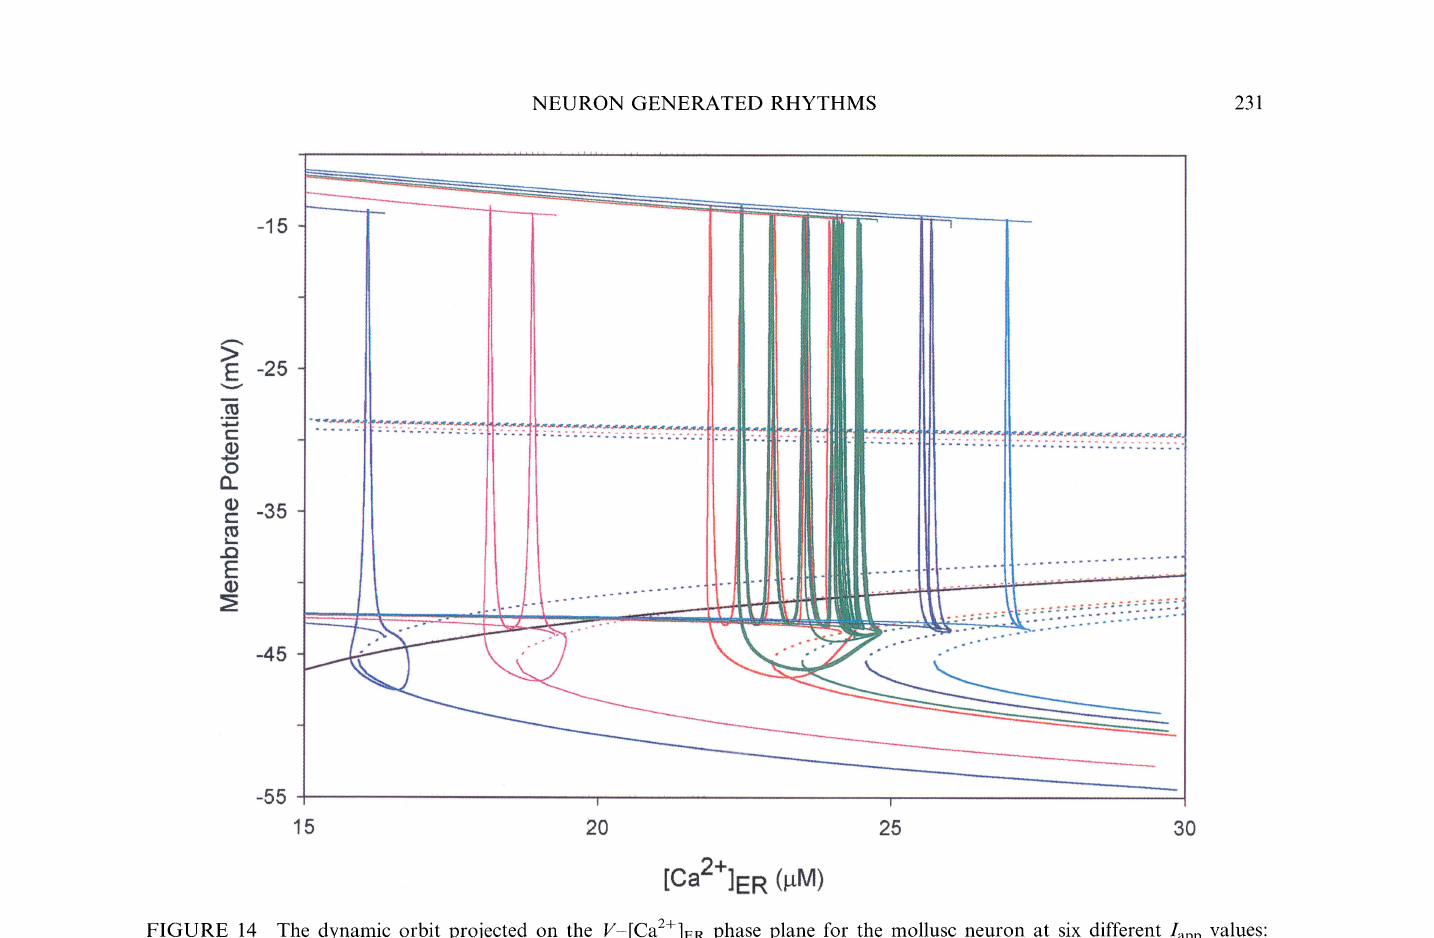
FIGURE 14 The dynamic orbit projected on the V--[Ca2+]ER phase plane for the mollusc neuron at six different lap values: lap p ----18 (blue), Iapp =-10.0 (pink), Iapp--0.0 (red), /app--1.0 (green), lap 3.0 (navy blue), and Iapp 5.0 /cm (turquoise). Here, the solid lines on the bottom represent SSSs, the dashed lines in the middle represent USSs. The top and middle solid lines are spiking envelopes. (See Color Plate